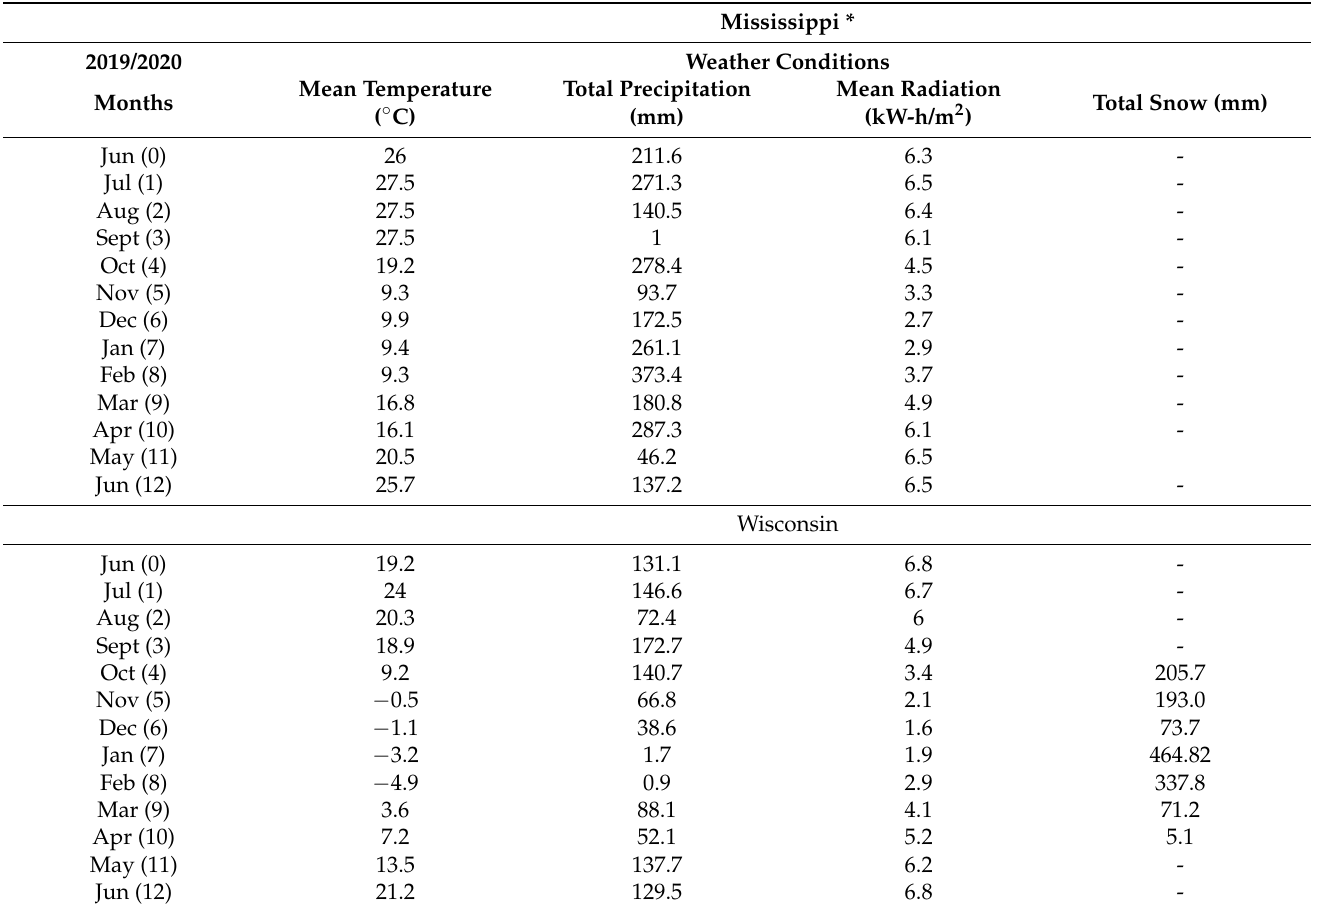
Table 2. Weather conditions in Mississippi and Wisconsin during natural outdoor exposure of coated and uncoated CLT samples, adapted from